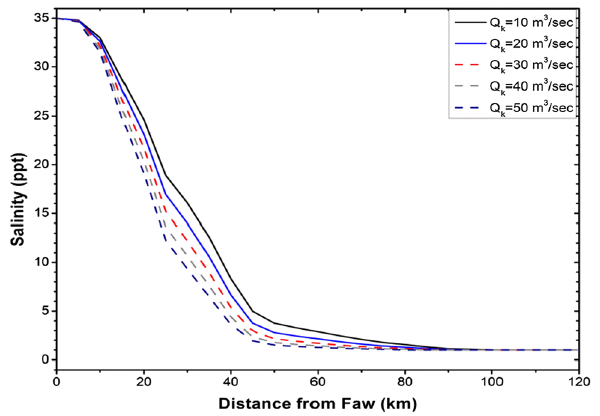
Fig. 7 Salinity intrusion limit when Tigris river closed, freshwater flow from Karun river